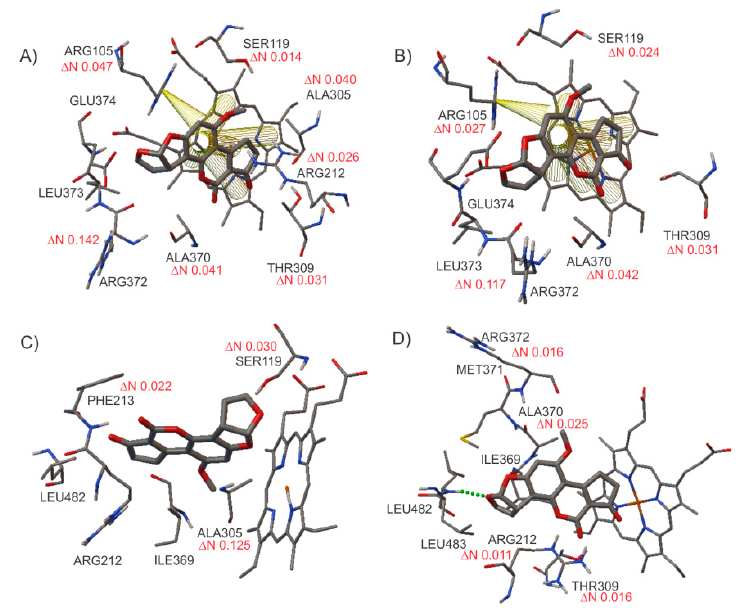
Figure 6. Schematization of the transferred electron values ( ∆ N) calculated for the interactions between AFB1 and the CYP3A4 protein. ( A ) ITQN, ( B ) 2V0M, ( C ) 1W0E, and ( D ) 4NY4. Values in red indicate electron donors.